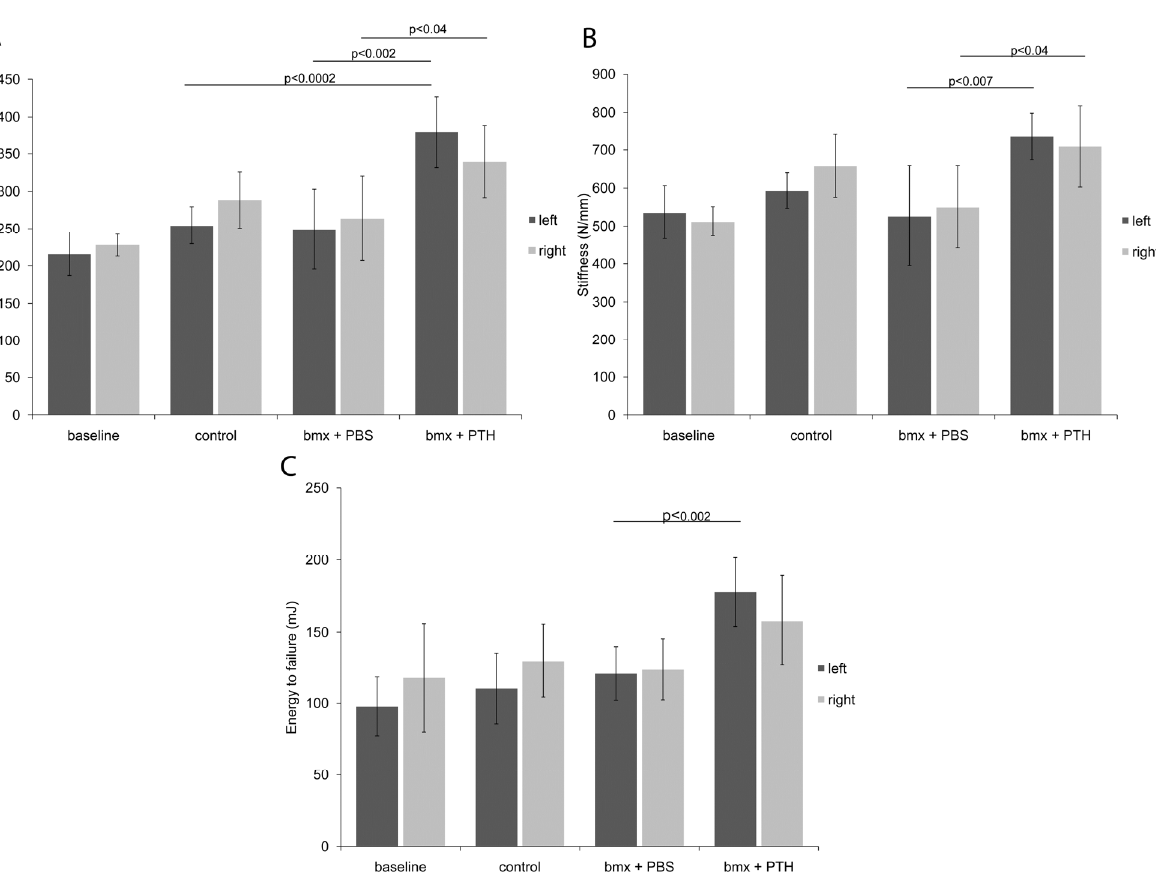
Figure 3. Biomechanical testing results from analysis of femoral shafts of left operated and right unoperated femurs from baseline, control and bone marrow-ablated (bmx) rats treated five days per week with PBS or PTH for 28 days. Right and left femurs were subjected to three-point bending to record ( a ) the ultimate force, ( b ) the energy to failure of femurs, and ( c ) the stiffness. PTH treatment improves mechanical properties of femoral shafts and augments the energy to failure when combined with marrow ablation. (n = 4–6 per